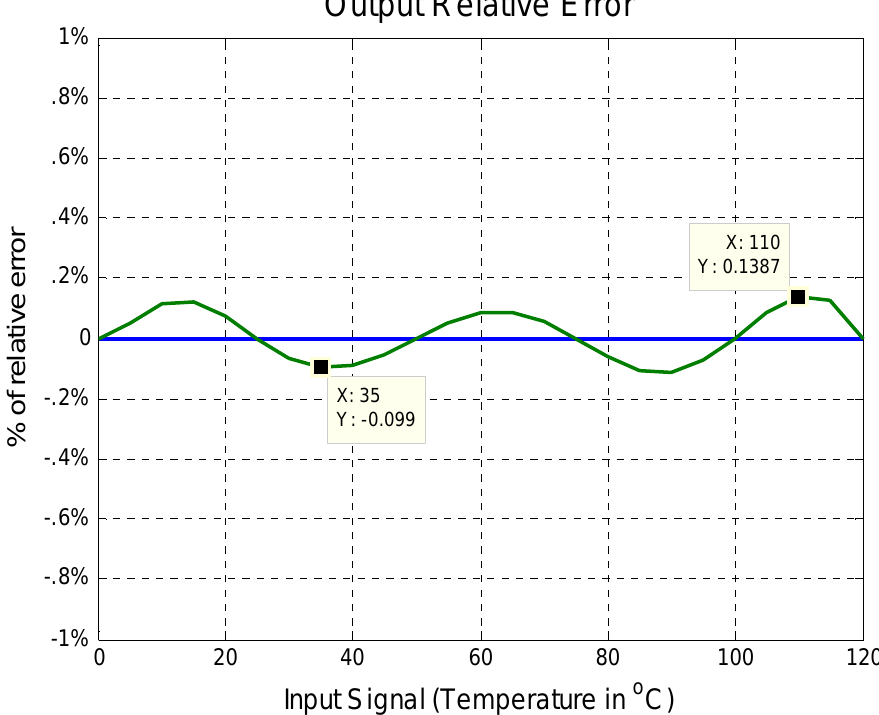
Figure 12. Improved algorithm relative error with six readjustment